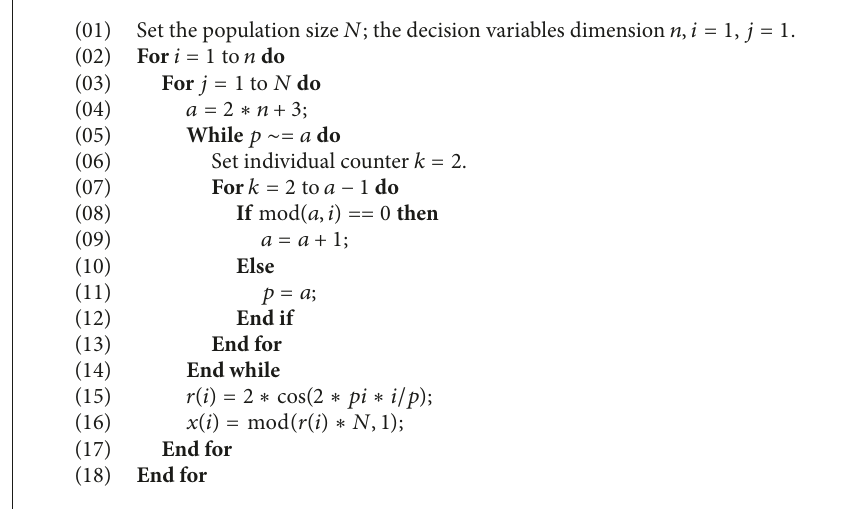
Algorithm 2: Good point set method.